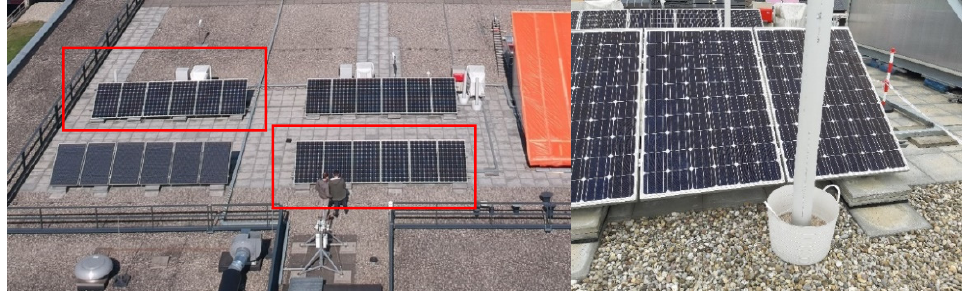
Figure 2. Drone picture of the two PV systems used for field testing ( left side ) and a shading element between two panels ( right side ).